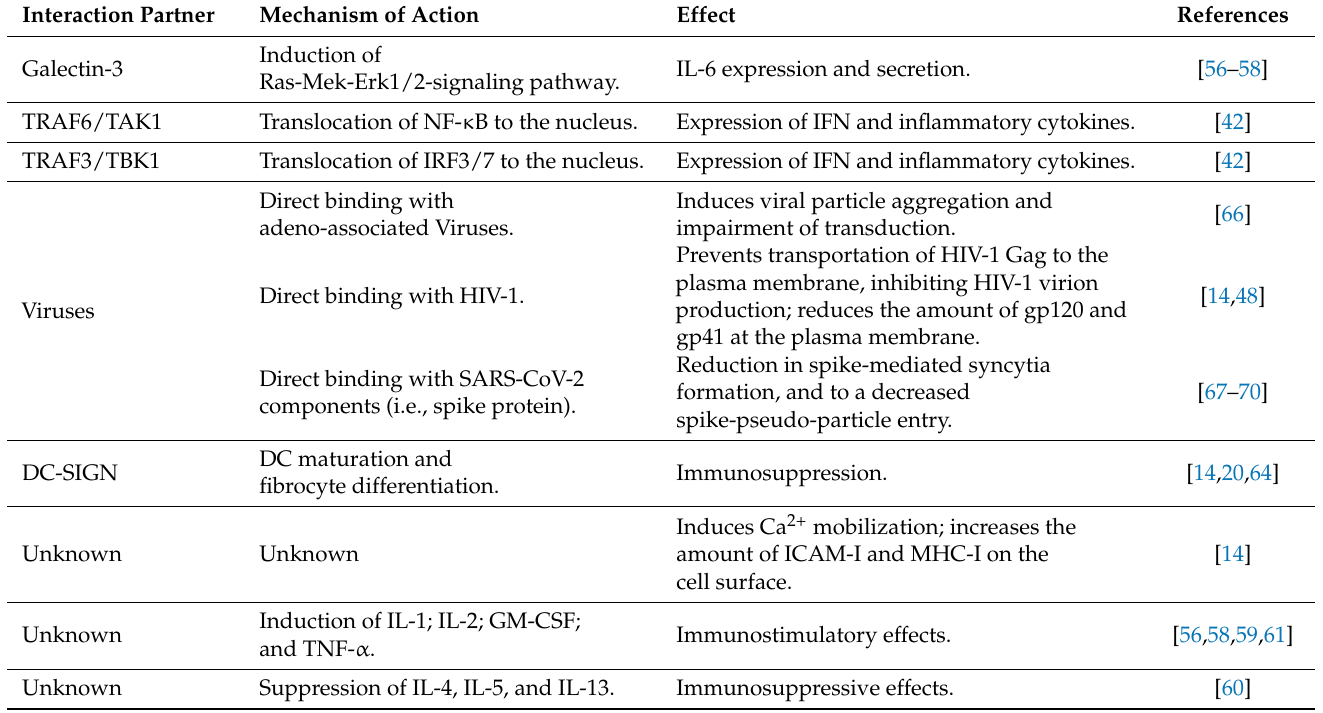
Table 1. Gal-3BP’s interaction partners, mechanisms of action, and reported effects during viral